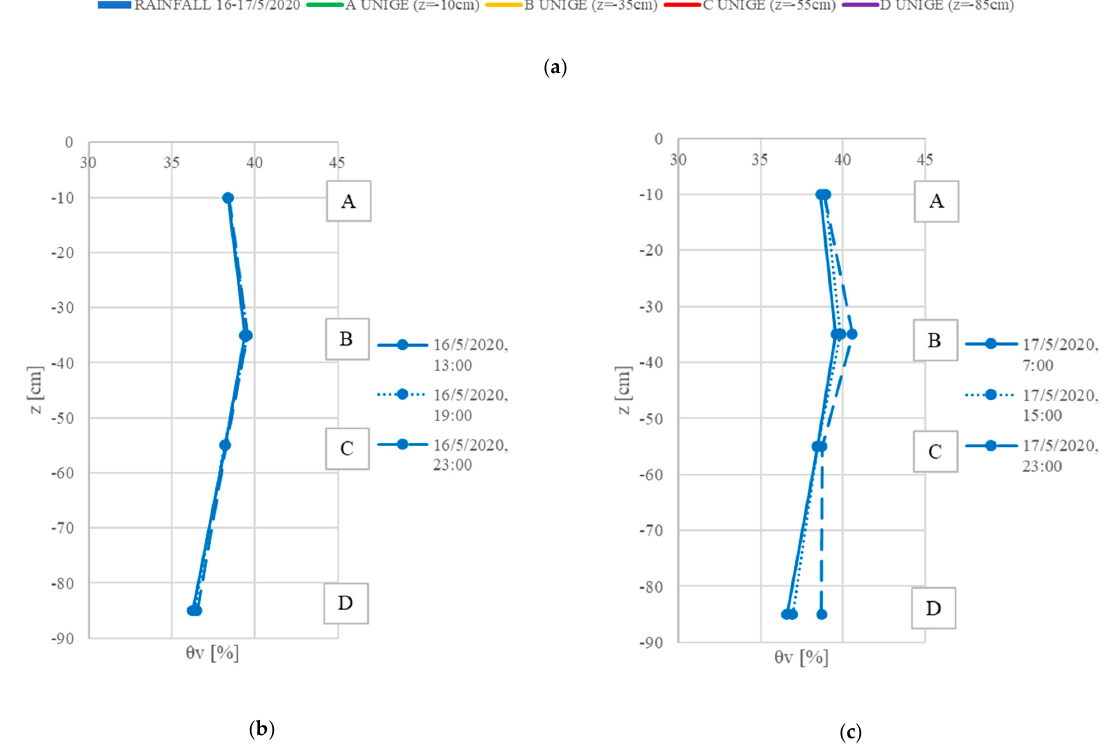
Figure 20. ( a ) May 2020 rainfall events and soil water contents; ( b ) Vertical soil moisture profiles 16 May